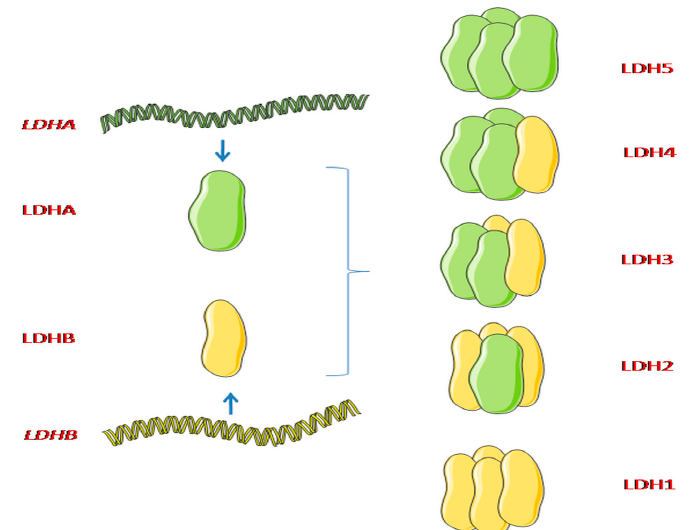
Figure 1. Lactate dehydrogenase (LDH) subunits and their combinations. Lactate dehydrogenase (LDH) consists of two different subunits: Lactate dehydrogenase A (LDHA) and lactate dehydrogenase B (LDHB). LDHA and LDHB can be assembled into combinations: LDH1 is composed from four LDHB subunits; LDH2 contains three LDHB subunits and one LDHA; LDH3 has two LDHB/LDHA subunits; LDH4 possesses one LDHB subunit and three LDHA subunits; while LDH5 is composed from four LDHA subunits [4]. Figure conception adapted from Doherty et al., (2013). Graphical elements adapted from Servier Medical Art.